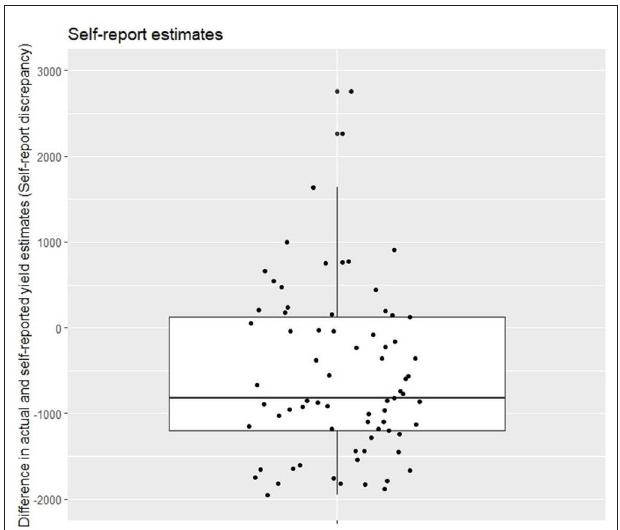
FIGURE 2 | Boxplot showing the accuracy of self-reported yield data when compared to satellite yield estimates of yield for the same field. Bolded line represents the median value, edges of the box represents the 25 and 75% percentile, and the whiskers represent + /– 1.5 of the interquartile range.